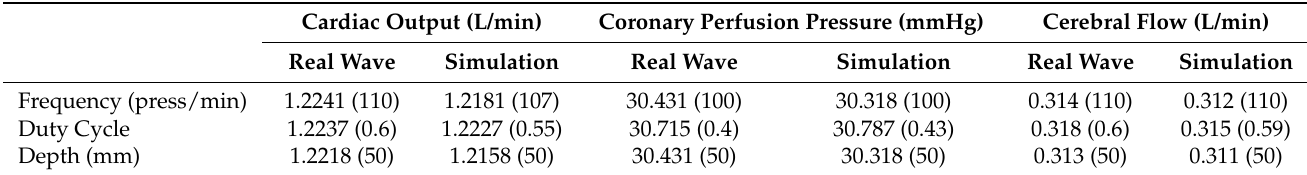
Figure 15. Relationship between depths and blood circulation results: ( a ) CO, ( b ) CPP, ( c ) CF. Table 4. Optimal parameters for compression. Cardiac Output (L/min)